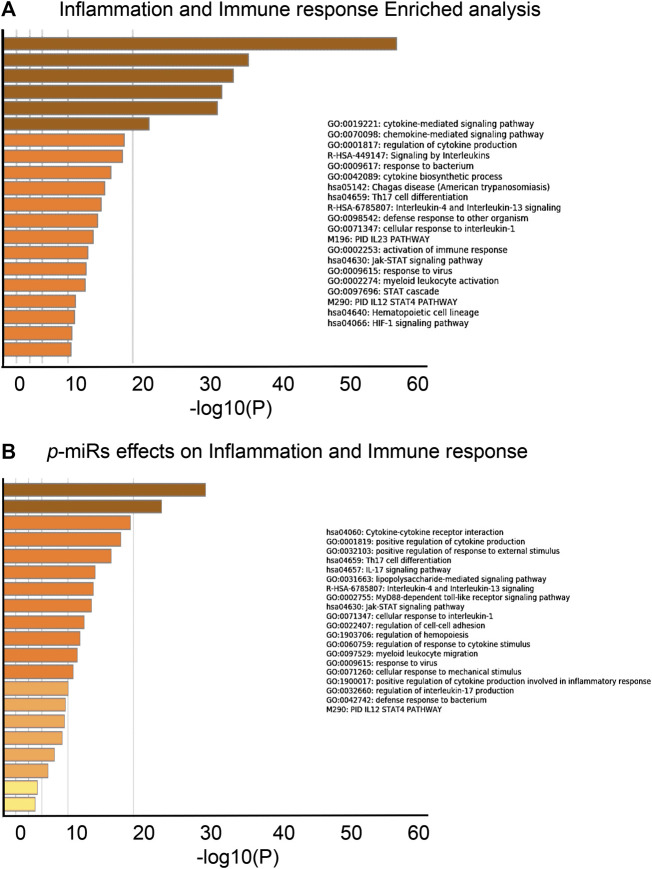
Biological processes enrichment analysis of putative p-miRs regulated genes. (A) Enrichment analysis related to the genes associated to immune response and inflammation. (B) Enrichment analysis related to the modulated gene by the most conserved MO p-miRs. Up to the top 20 enriched clusters are shown colored by p-values. All the statistically enriched terms were identified (GO/KEGG terms, canonical pathways, hall mark gene sets, etc.), accumulative hypergeometric p-values and enrichment factors were calculated and used for filtering. Then 0.3 kappa score was applied as the threshold to divide the tree into term clusters. Created by Metascape [http://metascape.org].